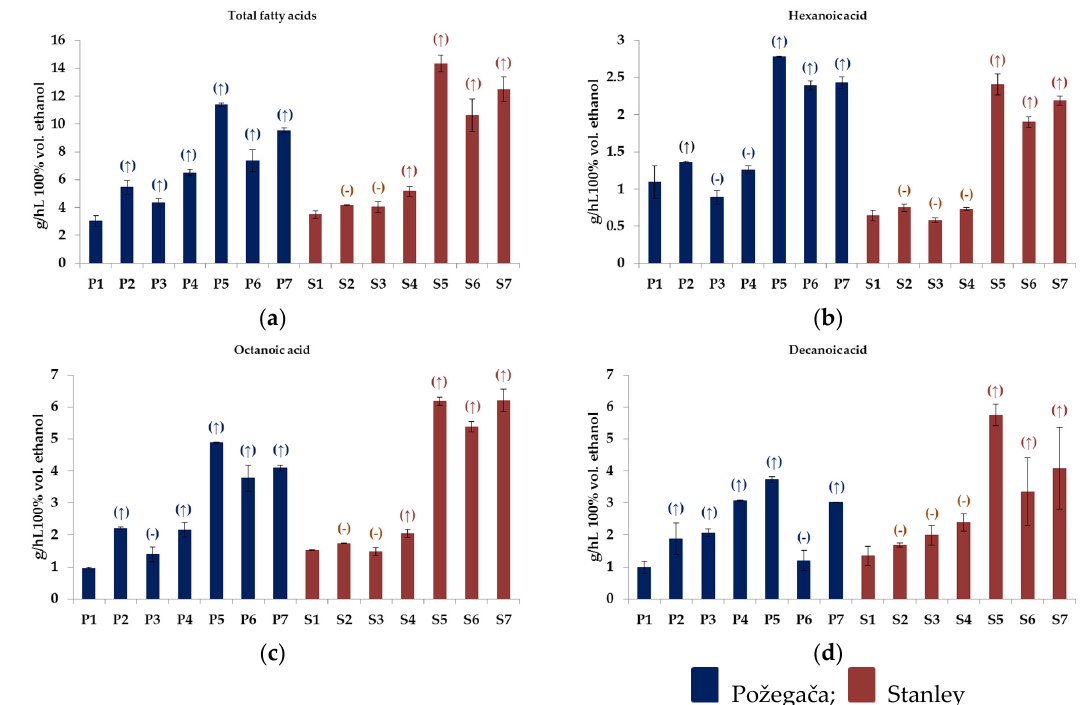
Figure 3. Content of fatty acids (g/hL 100% vol. ethanol) in plum spirits of Požegaˇca (P) and Stanley (S) varieties produced by traditional method (P1 and S1) and modified methods (P2–P7 and S2–S7): For each plum variety, different marks indicate differences in the means ( p < 0.05), according to Dunnett test: ( ↑ ) Statistically significant higher values compared to values in traditionally produced plum spirit, ( ↓ ): Statistically significant lower values compared to values in traditionally produced plum spirit, (-): No statistically significant differences in values compared to values in traditionally produced plum spirit. Concentrations of all parameters are shown as mean ± standard